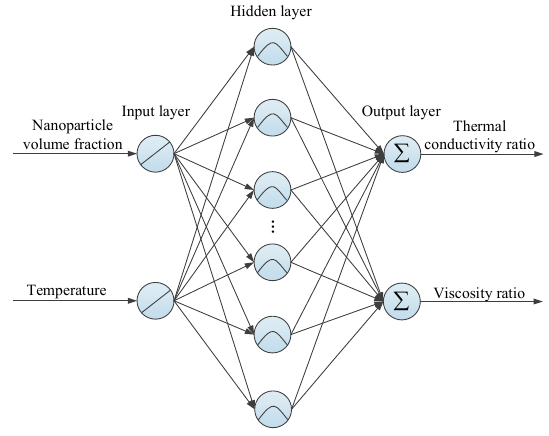
Figure 6. The RBF neural network developed in this study.